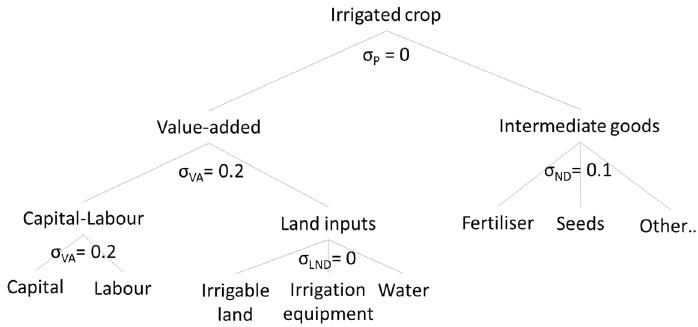
Figure 2. Production function of irrigated crops. The zero elasticity of substitution σ LND specifies land-related inputs as perfect complements.